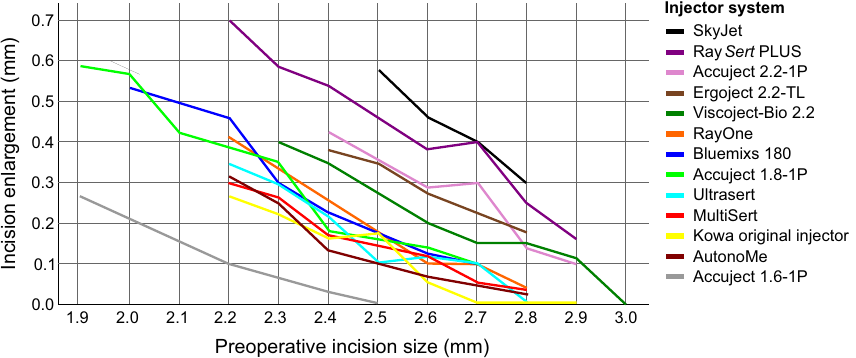
Figure 6. Interpolated means of intraoperative incision enlargement in varying preoperative incision sizes due to intraocular lens injector